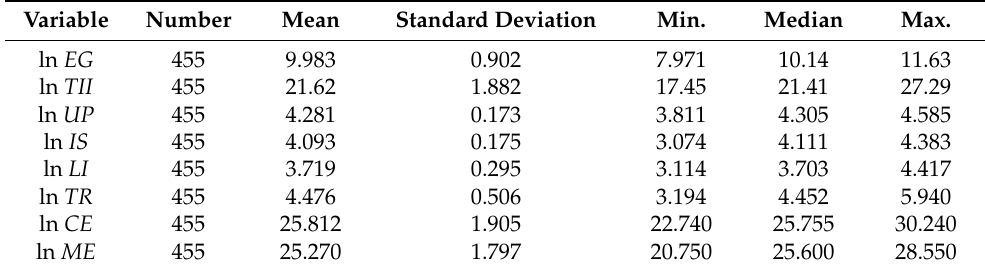
Table 3. Descriptive statistics of variables from 2007 to